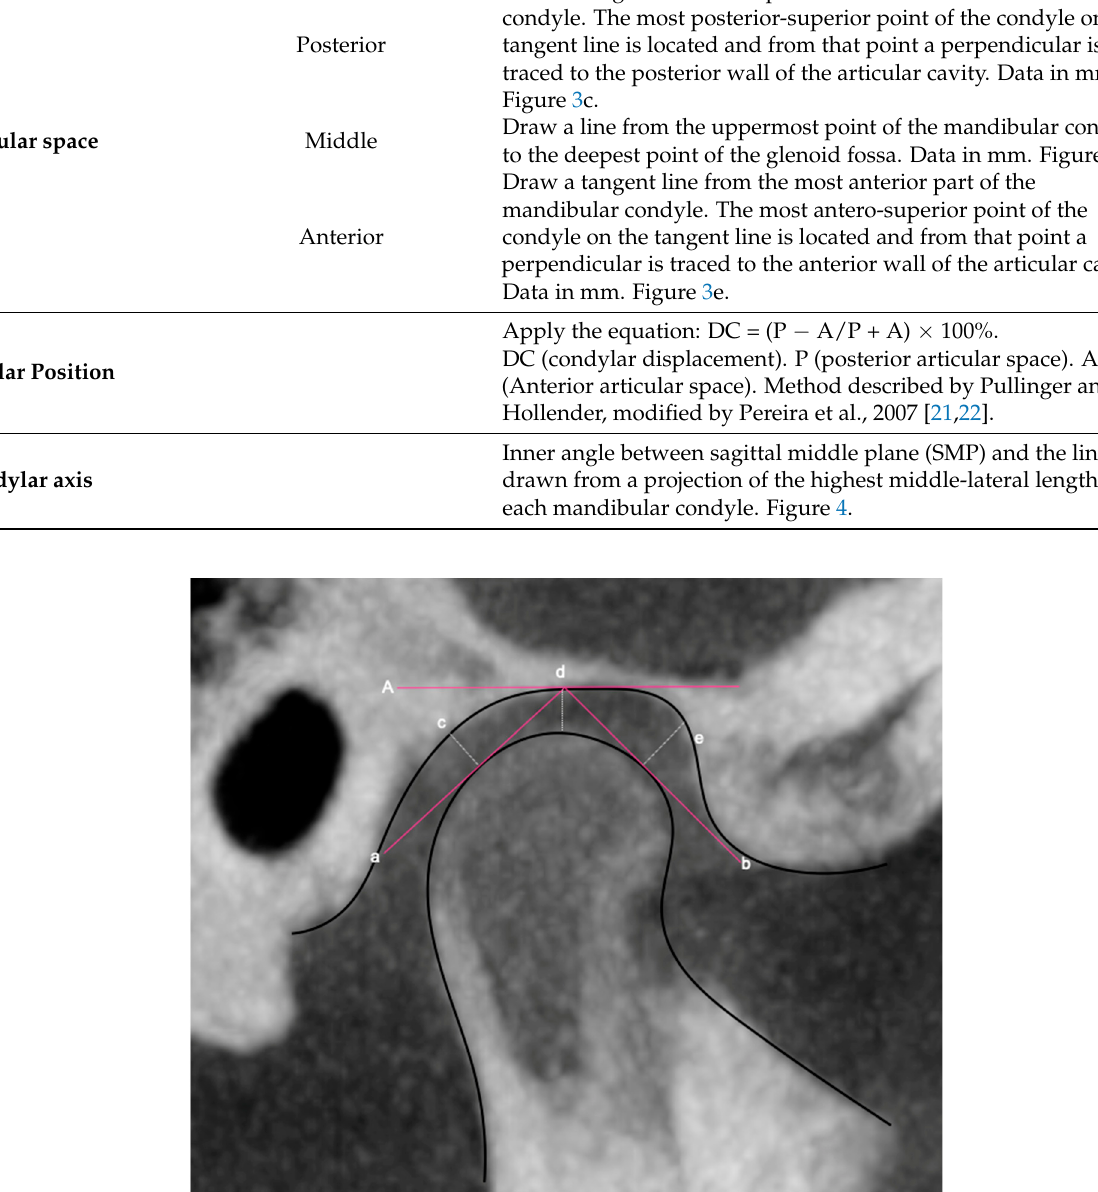
Figure 3. References for linear measurement of articular spaces (modified from Ikeda and Kawamura, 2009) [24]. A. True horizontal crossing the deepest point of glenoid fossa. a. Tangent line crossing the most posterior point of the mandibular condyle and the deepest point of the glenoid fossa. b. Tangent line crossing the most anterior point of the mandibular condyle and the deepest point of the glenoid fossa. c. Perpendicular from the most postero-superior point of the condyle on the tangent to the posterior wall of the glenoid fossa. d. Line from the most superior point of the mandibular condyle to the deepest point of the glenoid fossa. e. Perpendicular from the most antero-superior point of the condyle on the tangent to the anterior wall of the glenoid fossa. The distance in mm in these lines measures the anterior, middle and posterior articular space.